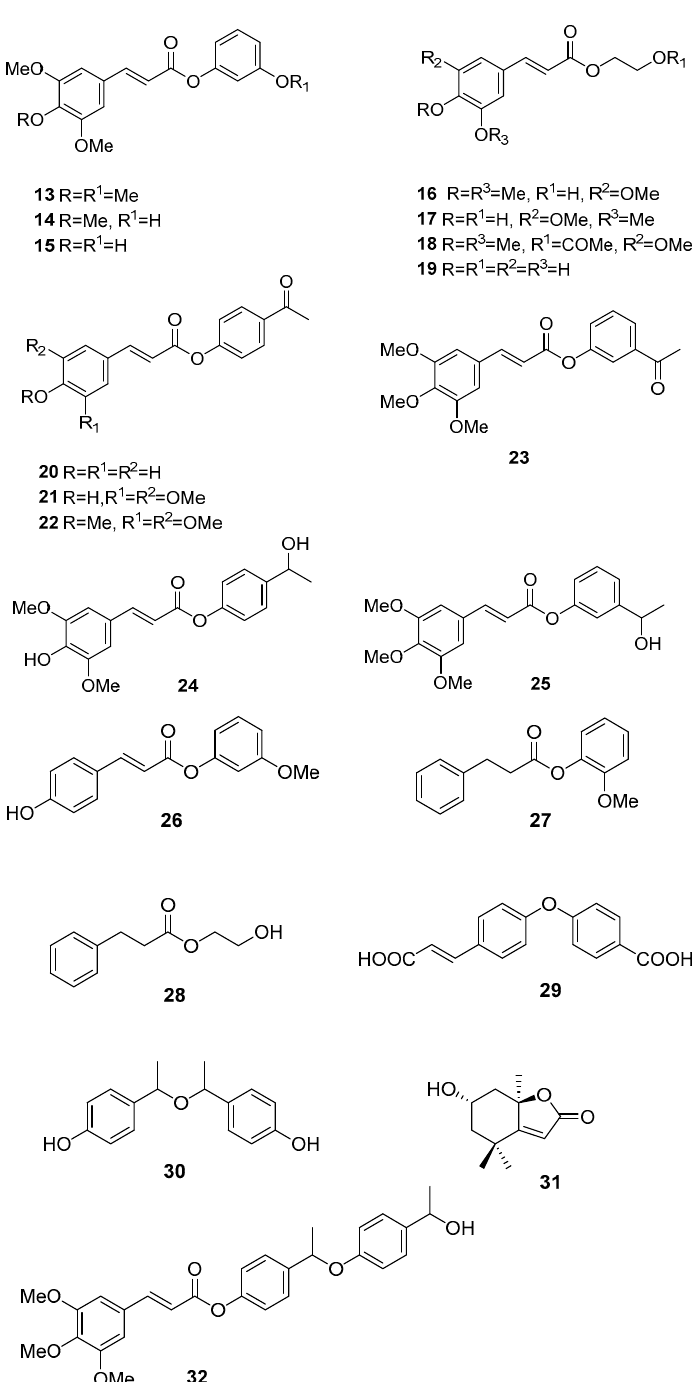
Figure 4. Compounds from Oxalis pes-caprae [37–40]. ( E )-3-methoxyphenyl 3,4,5-trimethoxycinnamate 13 , ( E )-3-hydroxyphenyl 3,4,5-trimethoxycinnamate 14 , 3-hydroxyphenyl sinapate 15 , ( E )-2-hydroxyethyl 3,4,5-trimethoxycinnamate 16 , 2-hydroxyethyl sinapate 17 , ( E )-2-acetylethyl 3,4,5-trimethoxycinnamate 18 , 2-hydroxyethyl caffeate 19 , 4 (cid:48) -acetylphenyl 4-hydroxycinnamate 20 , 4 (cid:48) -acetylphenyl 4-hydroxycinnamate 21 ,4 (cid:48) -acetylphenyl4- O -methylsinapate 22 ,3 (cid:48) -acetylphenyl4-methylsinapate 23 ,4 (cid:48) -(1-hydroxyethyl)phenyl sinapate 24 , 3 (cid:48) -(1-hydroxyethyl)phenyl 4-methylsinapate 25 , ( E )-3-methoxyphenyl 4-hydroxycinnamate 26 , 2-methoxyphenyl 3-phenylpropanoate 27 , 2-hydroxyethyl 3-phenylpropanoate 28 , ( E )-4-[4-(2- carboxyethenyl)phenoxy]benzoic acid 29 , 4,4 (cid:48) -[1,1 (cid:48) -oxybis(ethane-1,1-diyl)]diphenol 30 , loliolide 31 , and (E)-4-(1-(4-(1-hydroxyethyl)phenoxy)ethyl)phenyl 3,4,5-trimethoxycinnamate 32